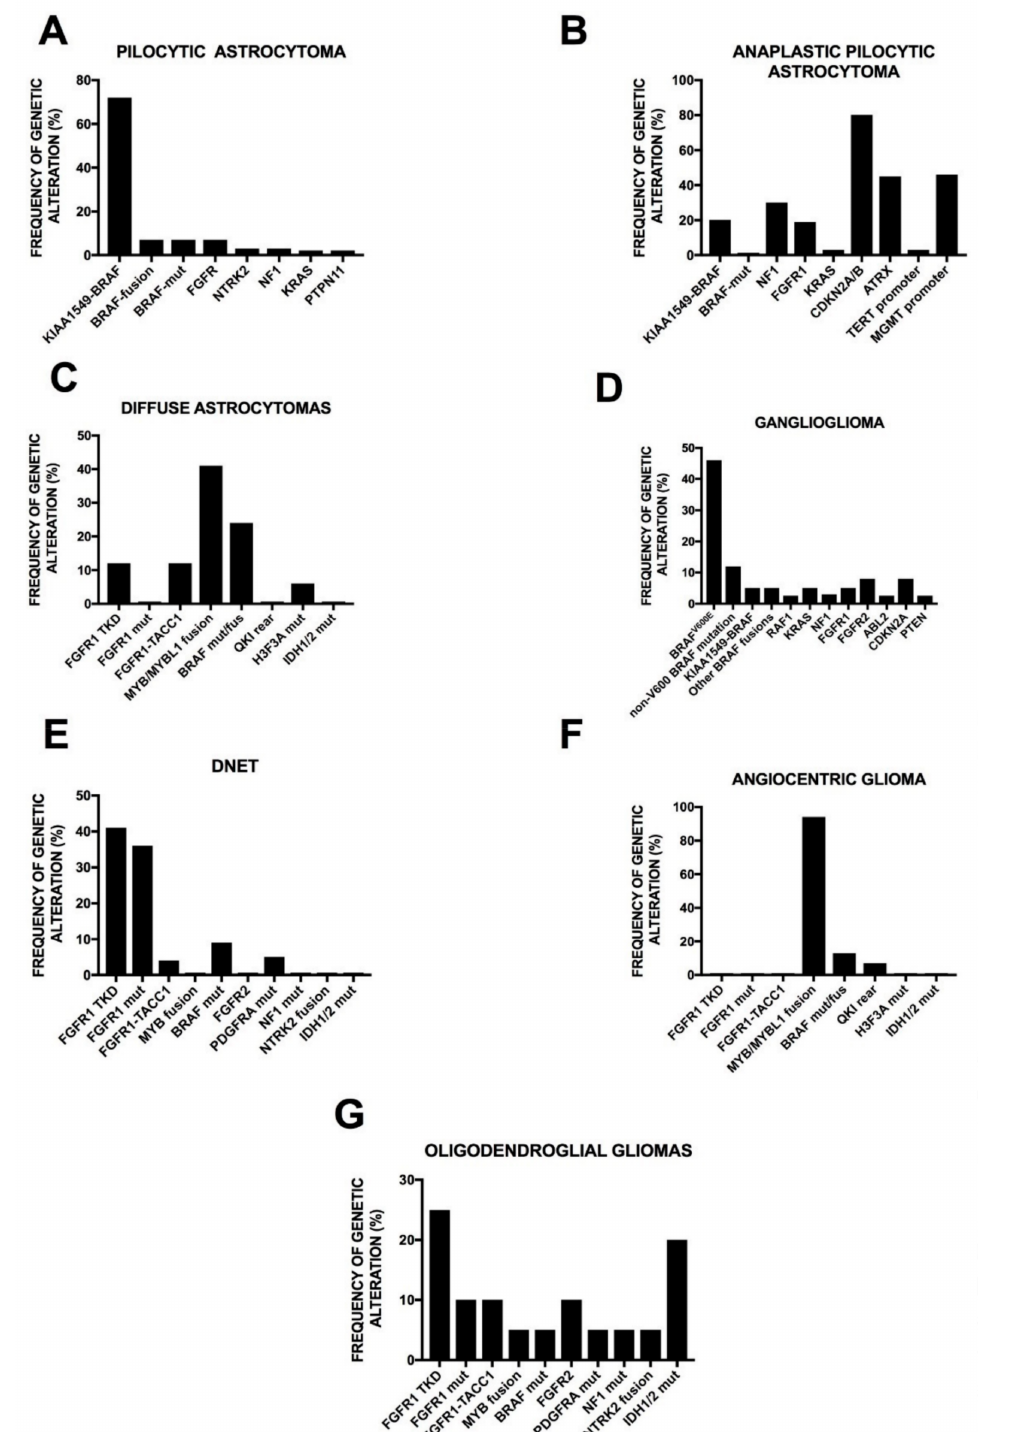
Figure 4. Genetic alterations observed in various types of low-grade pediatric gliomas: ( A ) Pilocytic astrocytoma; ( B ) anaplastic pilocytic astrocytoma; ( C ) diffuse astrocytoma; ( D ) ganglioglioma; ( E ) dysembryoplastic neuroepithelial tumor (DNET); ( F ) angiocentric glioma; and ( G ) oligodendroglial gliomas. For pilocytic astrocytoma, data are reported in a past paper [118]. For anaplastic pilocytic astrocytoma data are reported previously [127]. For diffuse astrocytoma data are reported in the literature [128,138]. For oligodendroglial gliomas data are reported previously